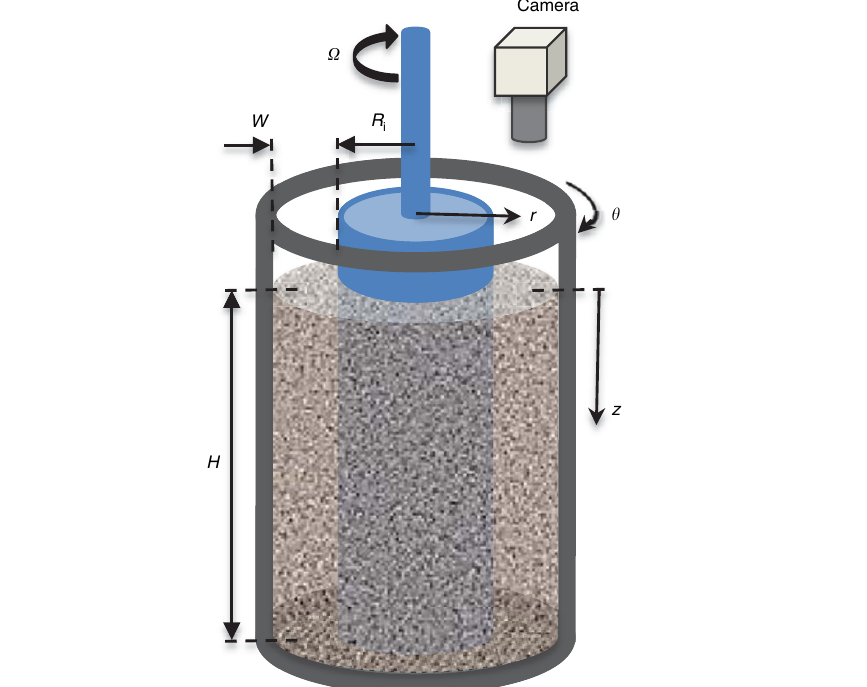
Figure 1 | Schematic diagram of the cylindrical Couette cell. The granular material is placed in the annular gap between the two coaxial cylinders of radii R i and R i þ W , and sheared by rotating the inner cylinder at constant angular speed O . The DEM simulations are for a Couette cell of dimensions R i ¼ 37 d p , W ¼ 16 d p , and H ¼ 30, 60 and 90 d p . The experiments use glass beads of mean diameter d p ¼ 0.83mm and a Couette cell of dimensions R i ¼ 72 d p , W ¼ 18 d p and H ¼ 300 d p